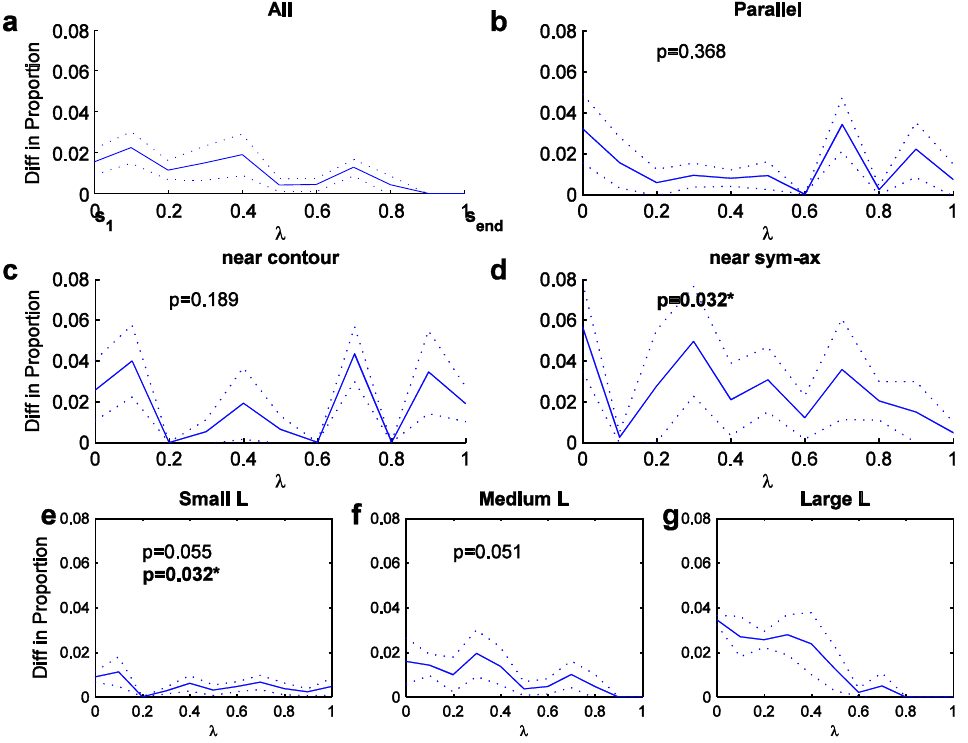
Figure 5. Longitude preference distribu-tions (averaged across scales; dotted curves outline width of standard deviation). X-axis: from s 1 (0) to s end (1).a. Preference for all fixations near elongated sym-axes. b. Preference for parallel sym-axes. for fixations near contour. d. Preference for fixations near sym-axes. e.-g. Longitude preference for L features of three angle bandwidths (angle